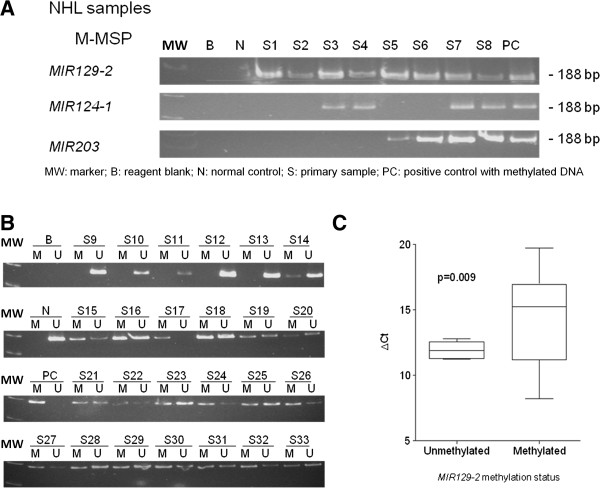
Methylation of MIR129-2 and expression of MIR129 in primary lymphoma samples. (A) Correlations of MIR129-2, MIR203 and MIR124-1 methylation in samples as shown by M-MSP analysis from 8 representative lymphoma samples. (B) M- & U-MSP analysis of MIR129-2 methylation and (C) stem-loop RT-qPCR analysis of MIR129 expression in 25 primary NHL samples with matched DNA and RNA. Box-and-whisker plot showed the MIR129 expression (ΔCt: Ct MIR129 – Ct SNORD48) in methylated and unmethylated primary NHL samples. The box indicated the 25th and 75th percentile and the whiskers represent the range. The horizontal line indicated the median. P-value was compared by two-sided Student t-test.